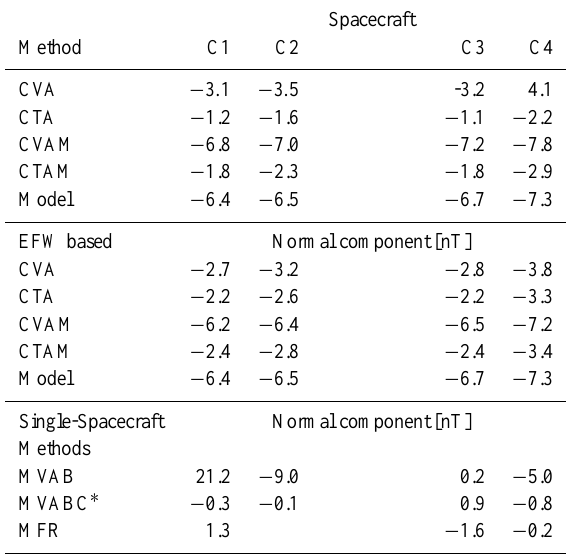
Table 3. Normal components h B i· n in units of nanotesla [nT] for the various